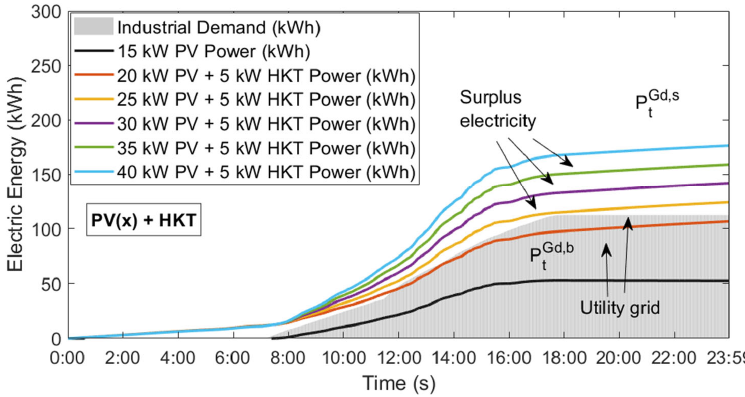
Figure 18. Sensitivity analysis with respect to PV capacity, HKT = 5 kW, WT = 0 kW, and LI = 50 kWh.